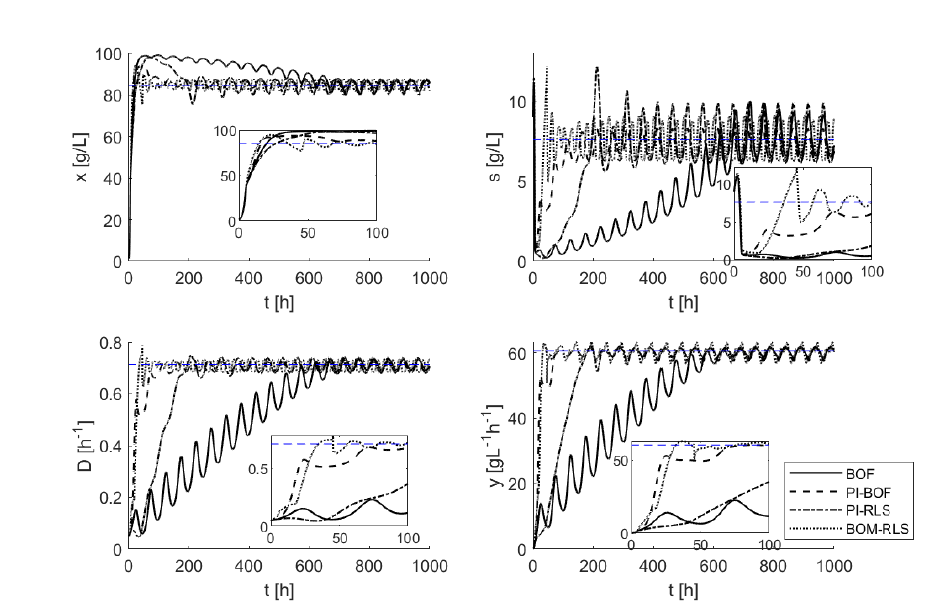
Figure 10. Application of the BOF, PI-BOF, PI-RLS, and BOM extremum seeking methods to optimize biomass productivity of microbial growth represented by model (3) with Haldane kinetics—state, input, and output time